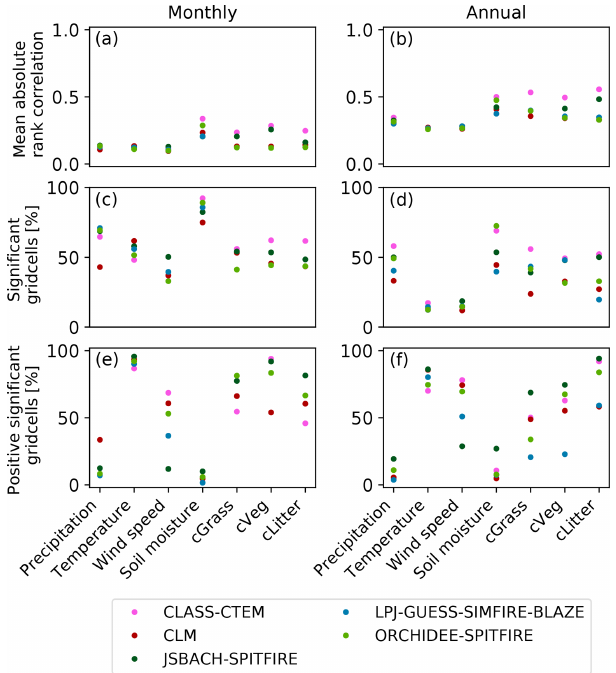
Figure A8. Spearman rank-order correlation coefficient for each grid cell over 1921–2013 for the difference between the baseline experiment SF1 and the sensitivity experiment SF2_CLI (see Table 1) for annual burned area fraction, precipitation, temperature, wind speed, carbon stored in litter, carbon stored in vegetation, carbon stored in grass and in soil moisture, respectively. Panels (a) and (b) show the mean absolute rank correlation, i.e. the spatial average over the absolute and significant ( p value < 0.05) Spearman rank-order correlation coefficients, in which the relative difference in burned area fraction is > 0 . 1. Panels (c) and (d) show the proportion of grid cells with a significant correlation. Panels (e) and (f) indicate the percentage of significant grid cells with a positive